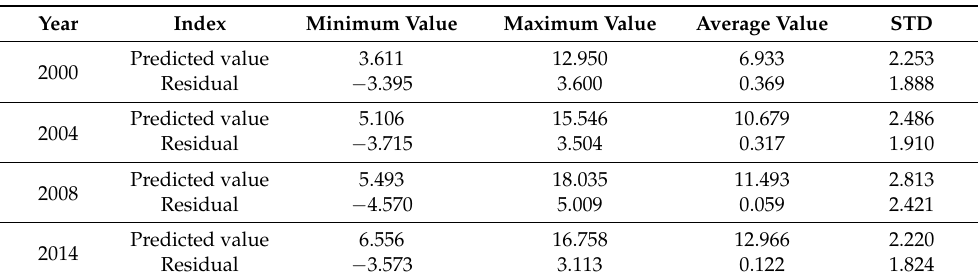
Table 5. Statistical analysis of the model prediction and residual. Table 3. Statistical analysis of the model prediction and